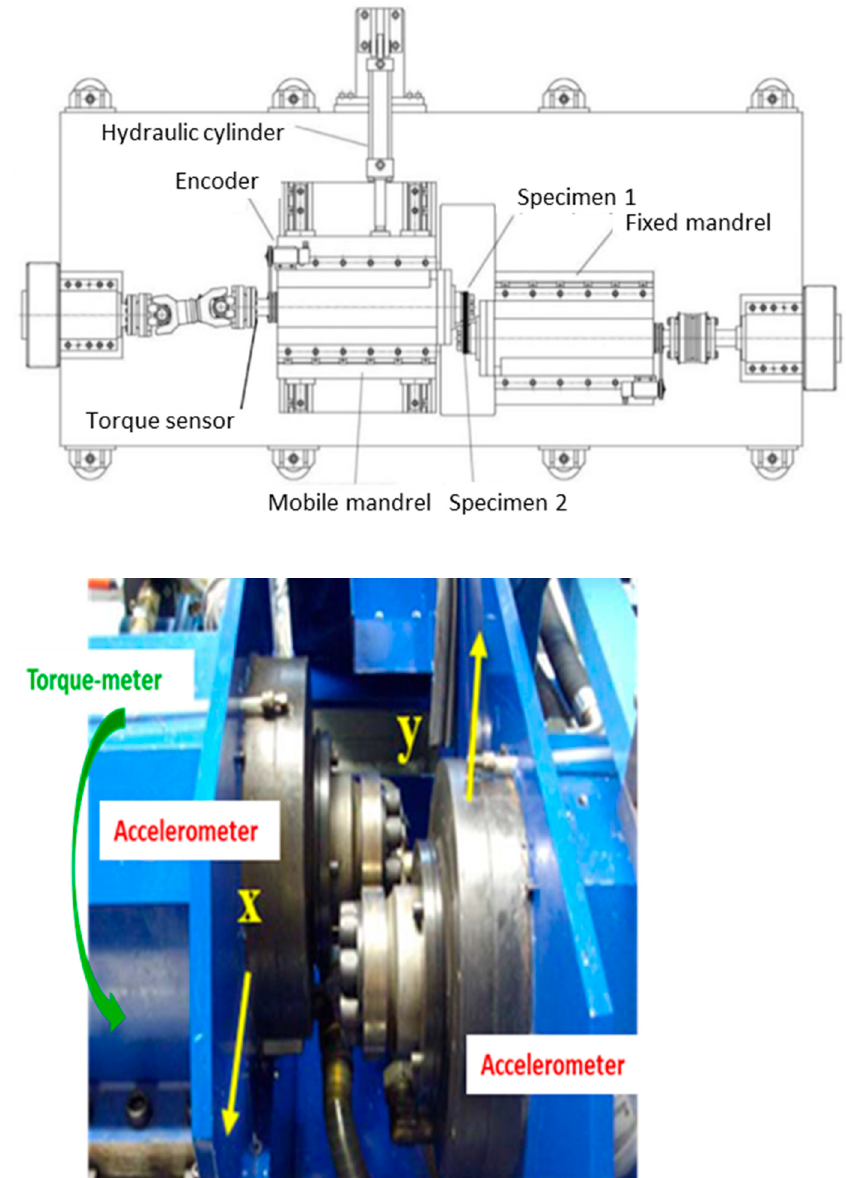
Figure 1. Schematic of the test rig (top) accelerometers and torque-meter positions (bottom).